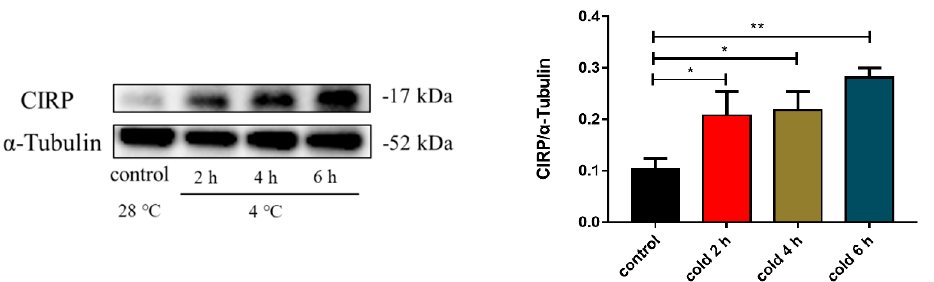
Figure 5. Effect of acute cold exposure on the level of cold-inducible RNA-binding protein (CIRP) expression in C57BL/6 mouse livers. The data are presented as the mean ± SEM ( n = 8). Statistically significant differences are indicated; * p < 0.05 and ** p < 0.01.